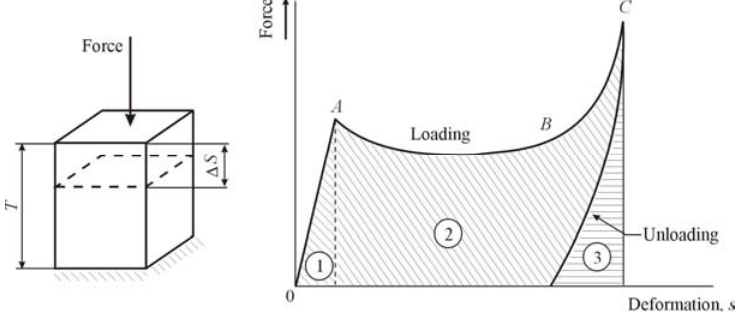
Fig 2. Force and shift interdependence of porous